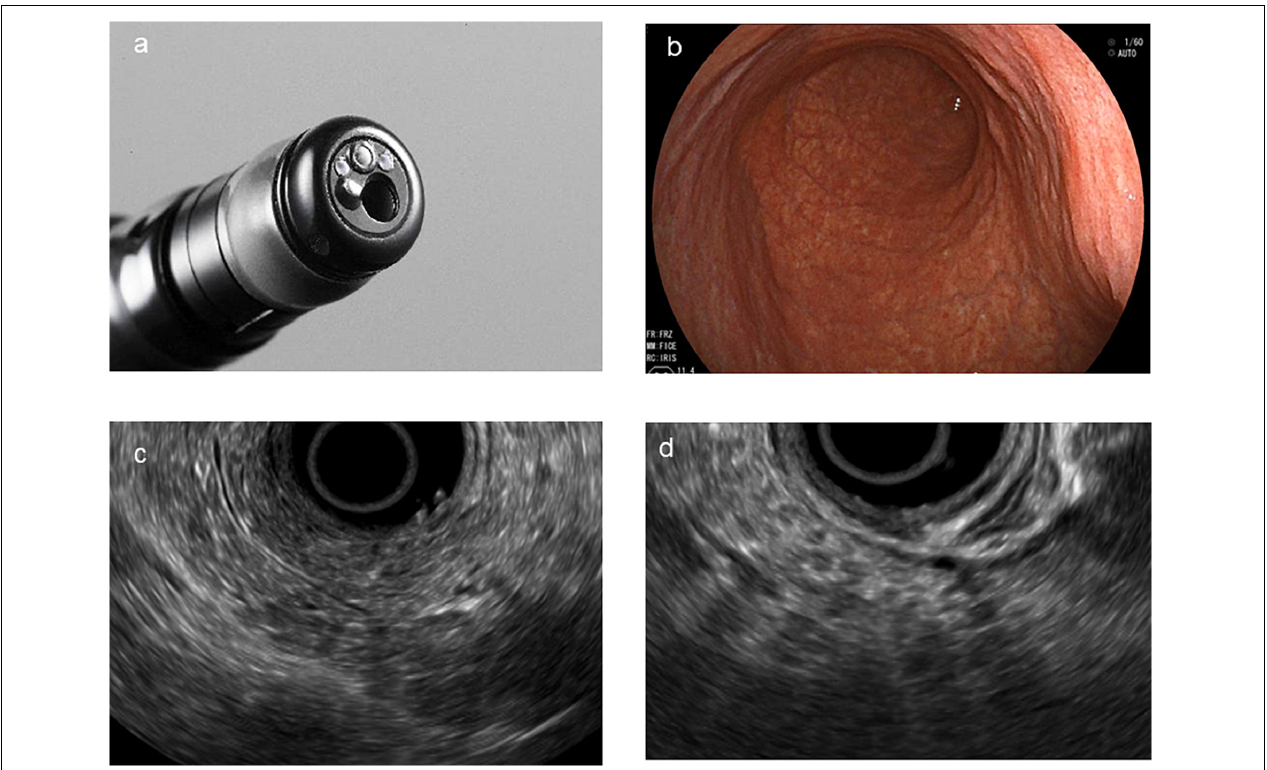
FIGURE 2 | Direct forward-viewing radial endoscopic ultrasound (FR-EUS). (a) The image of the tip of FR-EUS. (b) Endoscopic view of the stomach. (c) EUS image showing echogenic foci, echogenic strands, and echogenic ductal walls. (d) EUS image showing typical lobularity.